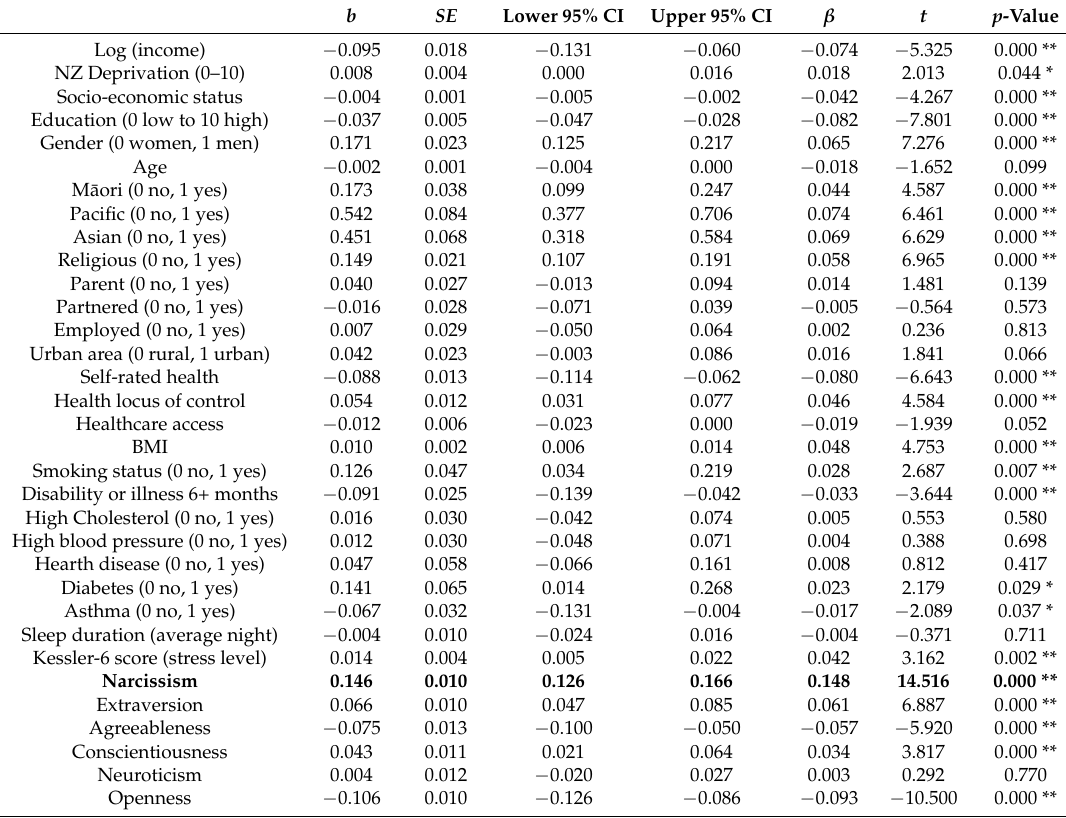
Table 2. Regression predicting level of entitlement to receiving antibiotic prescriptions by default when visiting their doctor with a minor